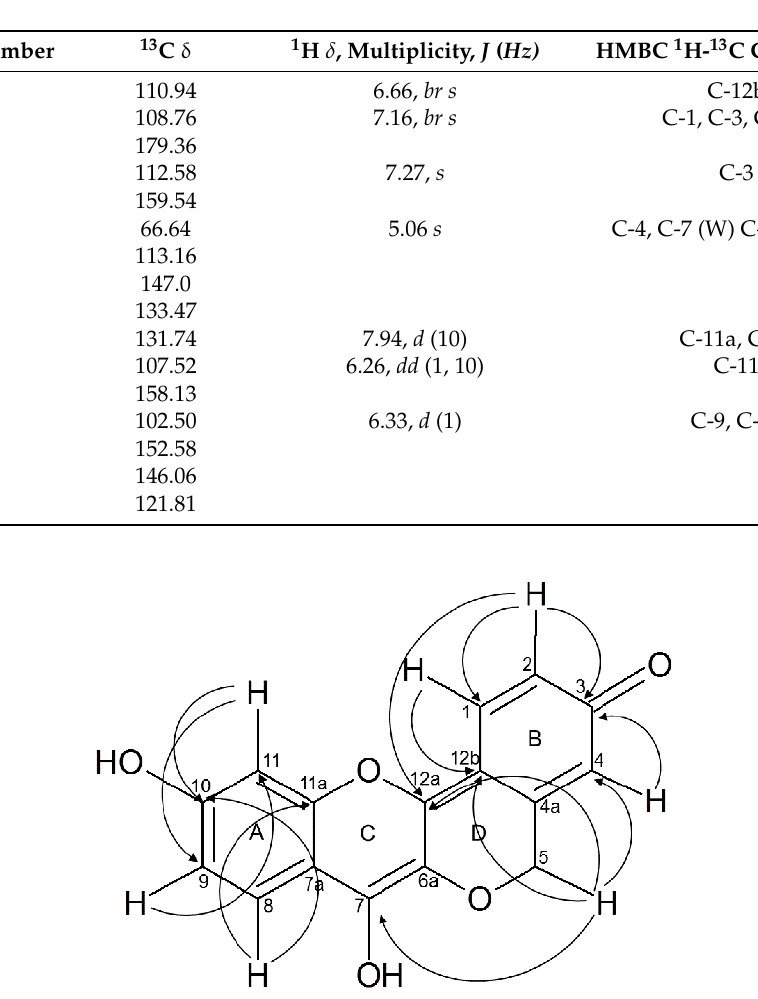
Table 1. 1 H- (500 MHz) and 13 C-NMR (125 MHz) (296 K in methanol- d 4 ) spectroscopic assignments for peltomexicanin.